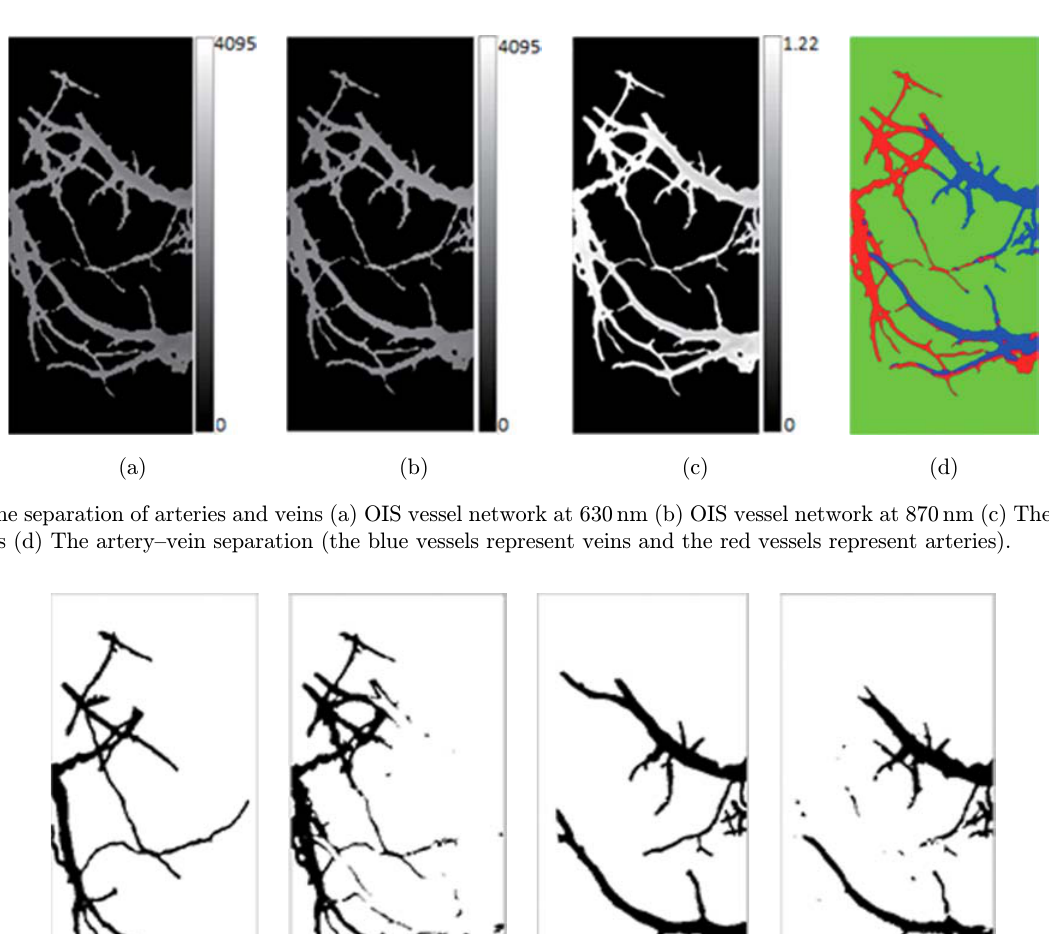
Fig. 4. Vessel segmentation (a) LSI (b) the manual segmentation (c) the segmentation with SRG.